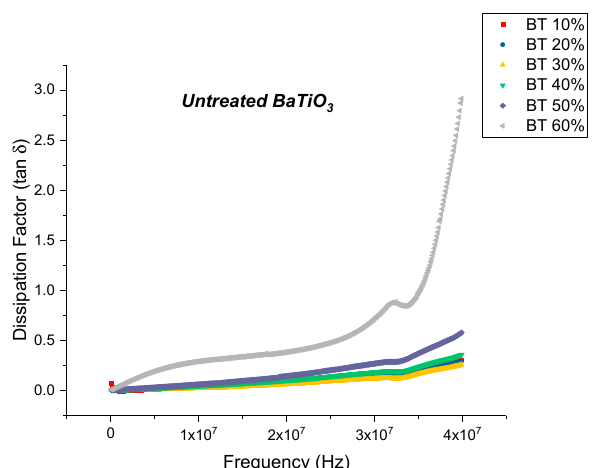
Figure 5. The dissipation factor of the BaTiO 3 -epoxy composite that were fabricated using untreated BaTiO 3 nanoparticles is plotted as a function of frequency where the volume fraction of BaTiO 3 is varied from 0.1 to 0.6. The maximum dissipation factor at 20 MHz was recorded to be 0.3836 at a volume fraction of 0.6 of BaTiO 3 .